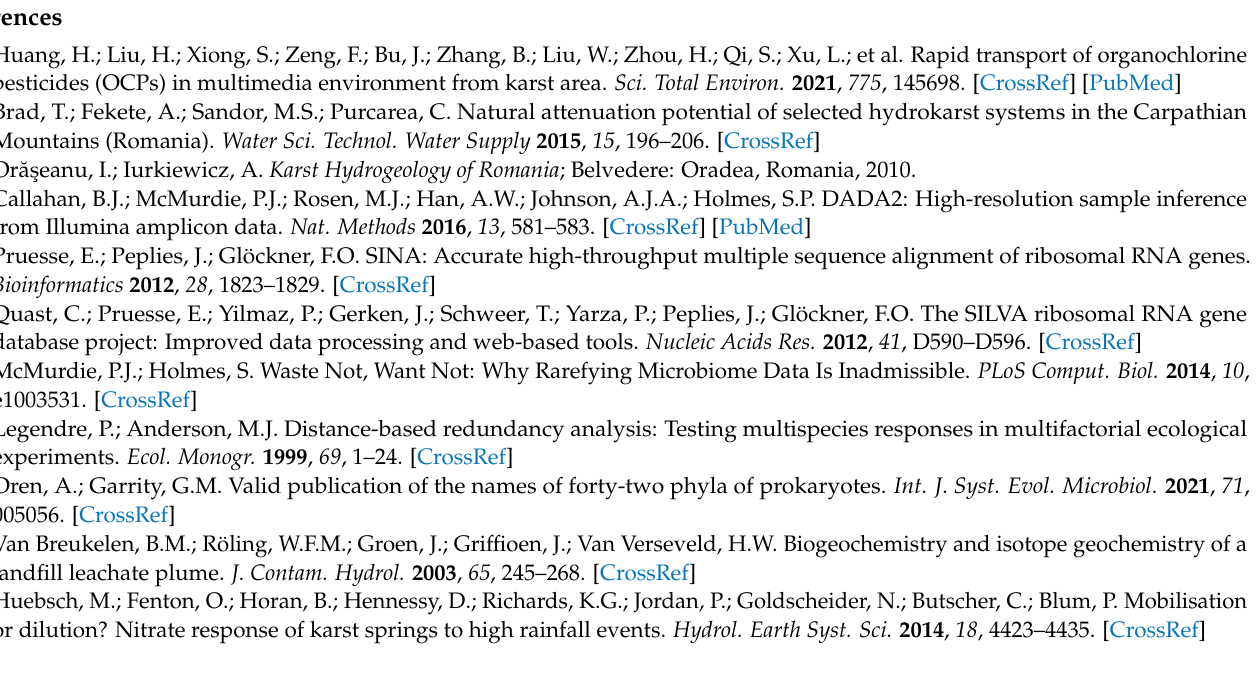
table with read counts and calculated relative abundance for the different taxa obtained in samples collected from the end points of the five investigated HKS. Table S2: Alpha diversity measures. Table S3: Overview of the most frequent microorganisms occurring in samples collected from both ends of the selected hydrokarst systems. Multiple amplicon sequence variants were summed up into one genus. The significance of change between upstream and downstream was calculated by normalizing the abundance of each taxon between 0 and for each time point and site. The shown P value was obtained at the ASV level and is reflected in Figure S1. Table S4: Raw measurements of the different chemical